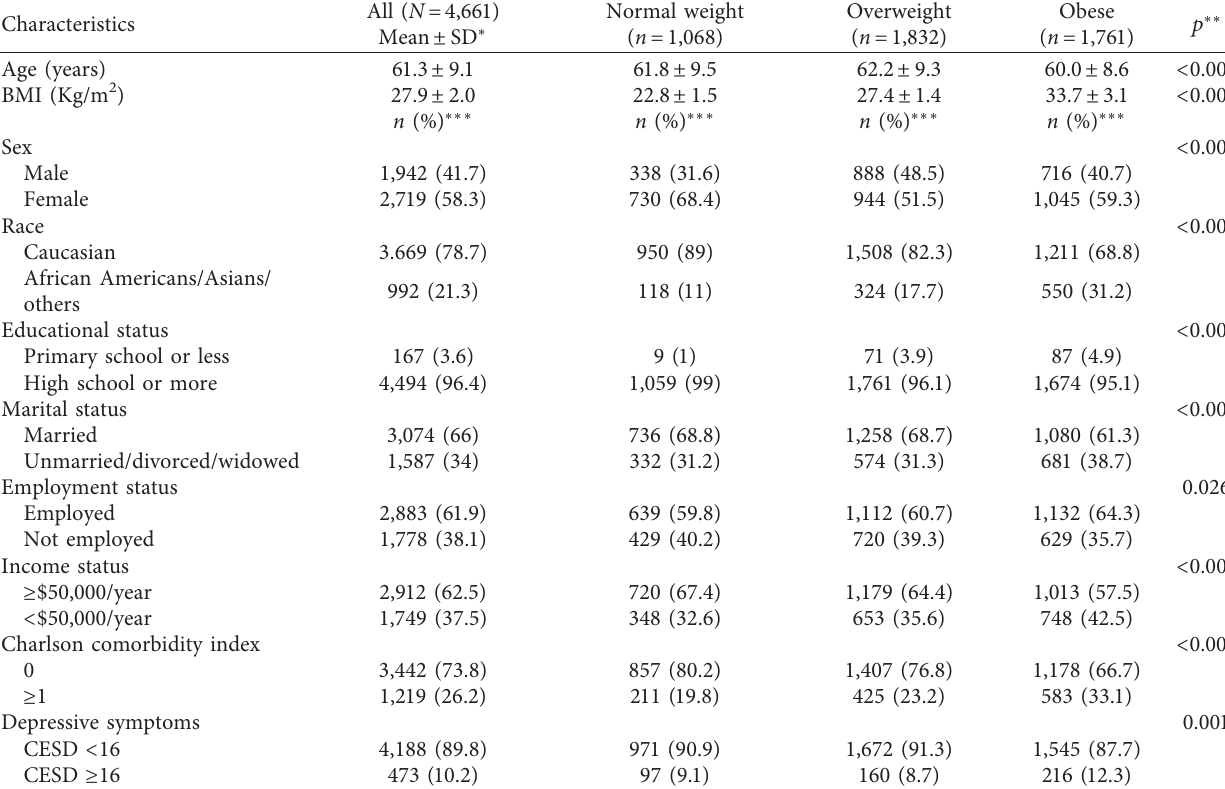
Figure 1: The flow of samples from the Osteoarthritis Initiative Study ∗ . † Participants with symptomatic tibiofemoral knee osteoarthritis at baseline. ≠ Participants with no symptomatic tibiofemoral osteoarthritis in either knee at baseline, but had an elevated risk of developing symptoms of knee osteoarthritis during the study. § Participants with no pain, aching, or stiffness in either knee in the past year, along with no radiographic findings of osteoarthritis and no eligibility risk factors. ¶ Data are missing for the variable indicating which knee was eligible for the study. BMI: body mass index. Table 1: The demographic characteristics of the study participants according to their body mass